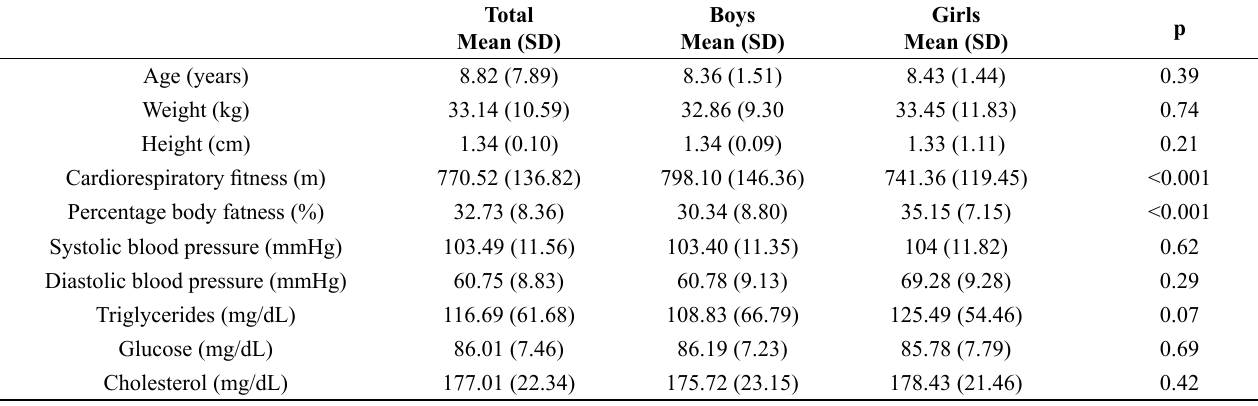
Table 1. Characteristics of the study samples according to sex in children.